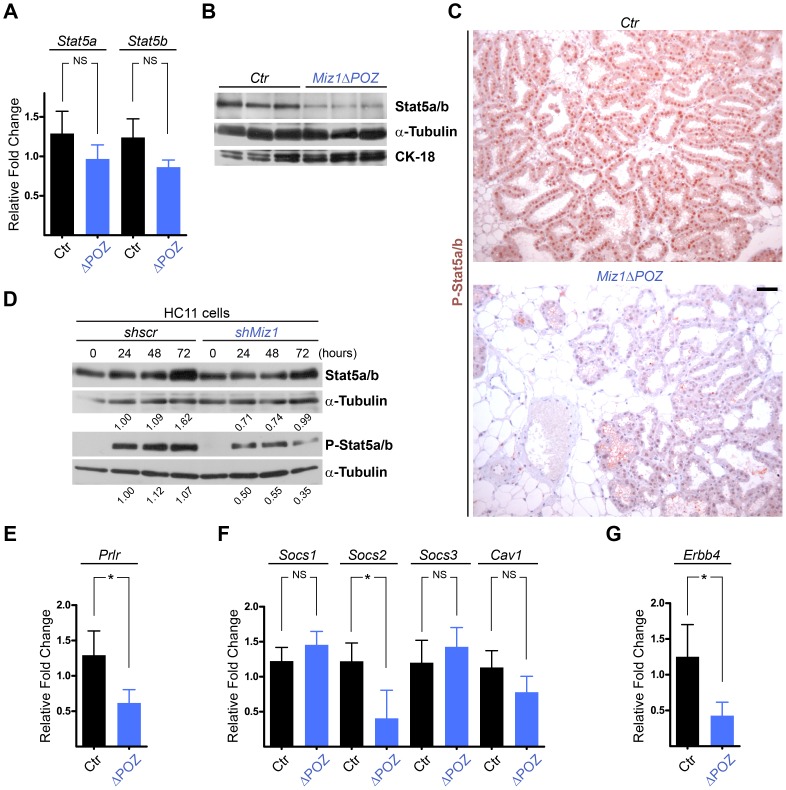
Stat5 phosphorylation is reduced in Miz1ΔPOZ mammary glands and in shMiz1 HC11 cells.(A) Analysis of Stat5a/b mRNA expression in Miz1ΔPOZ (ΔPOZ) and control mammary gland tissue (Ctr). (B) Immunoblot analysis of Stat5 in wildtype and Miz1ΔPOZ mammary glands. (C) Immunohistochemical staining of pStat5 in the mammary gland tissue from wildtype and Miz1ΔPOZ animals. (D) Western blots from HC11 cells stably transfected with a scrambled short hairpin (sh) RNA (shscr) or a Miz1 shRNA (see also Fig. 4E and F). Numbers indicated are fold changes of band intensities obtained by densitometry (see Materials and Methods). Quantitative RT-PCR for the prolactin receptor (E; Prlr), the Supressors of cytokine signalling (Socs) 1, 2 and 3 and caveolin-1 (F; Cav1), and for ErbB4 (G). Lactation day 6 samples were used in all in vivo experiments. Scale bar in C: 50 µm.